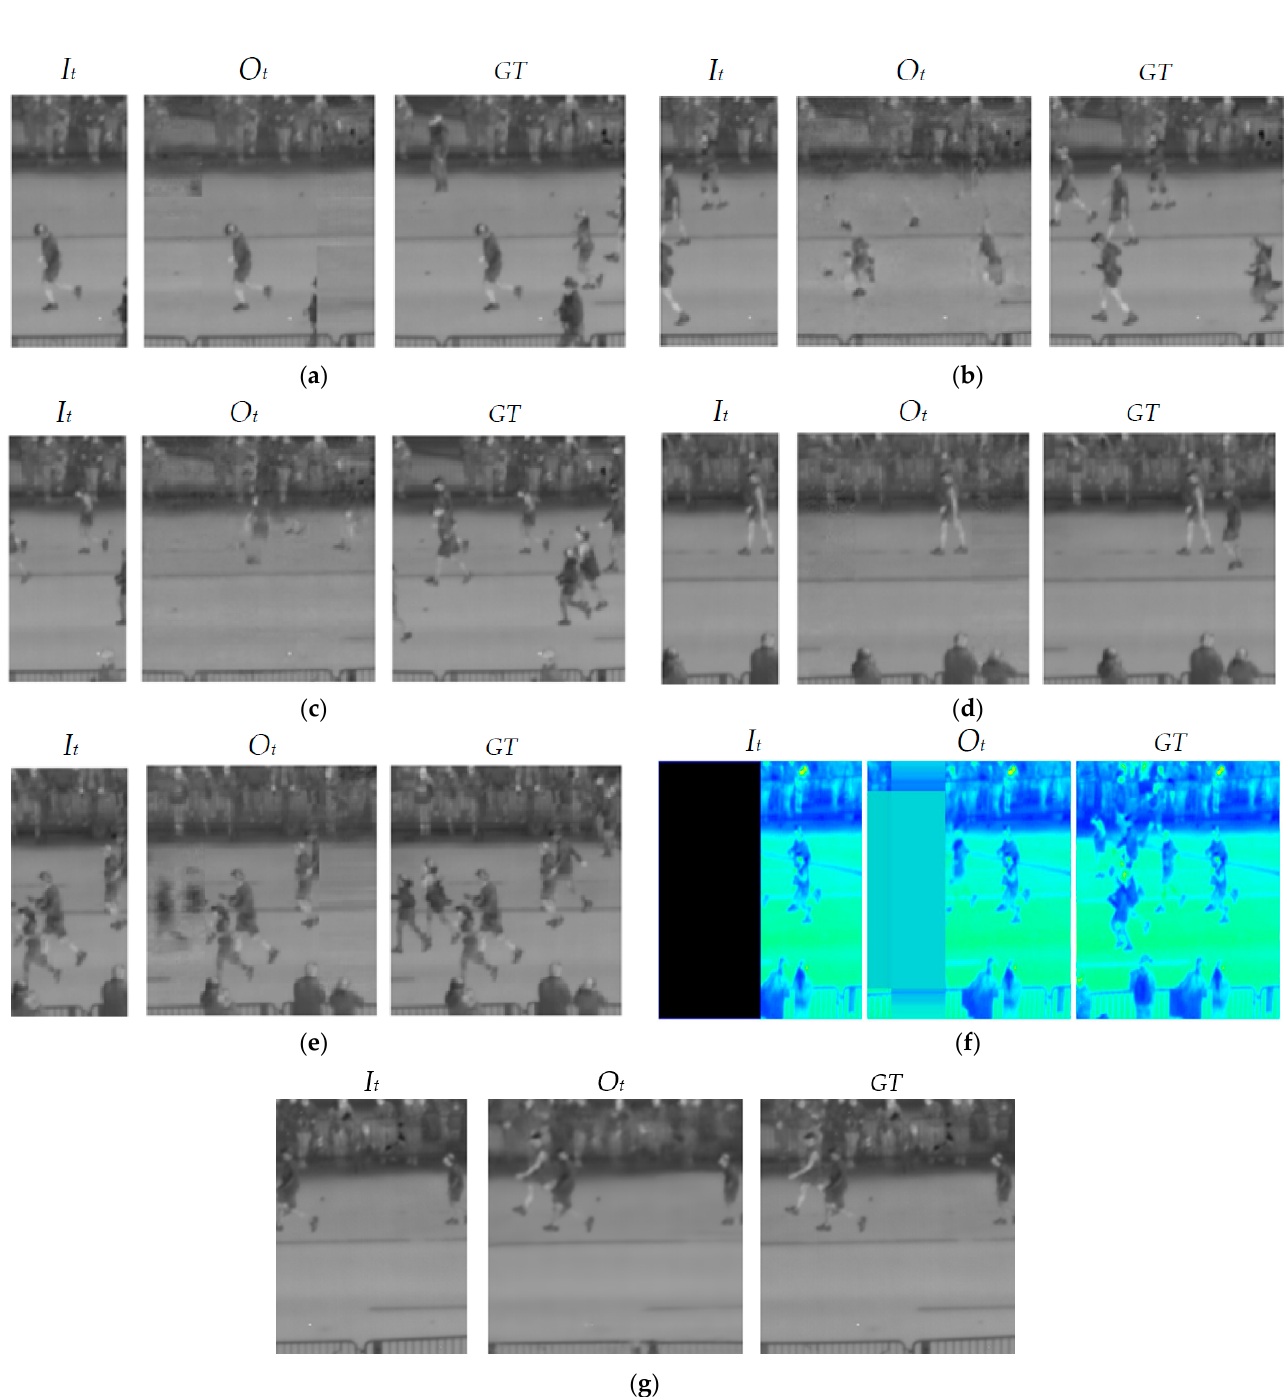
Figure 7. Examples of result images obtained by various methods: from left to right, input, output, and GT images obtained by ( a ) pred2reg, ( b ) predWholeIm, ( c ) 2-chanPred, ( d ) singImPred, ( e ) seq&sing, ( f ) pred3-chan [14], and ( g ) predLreg.